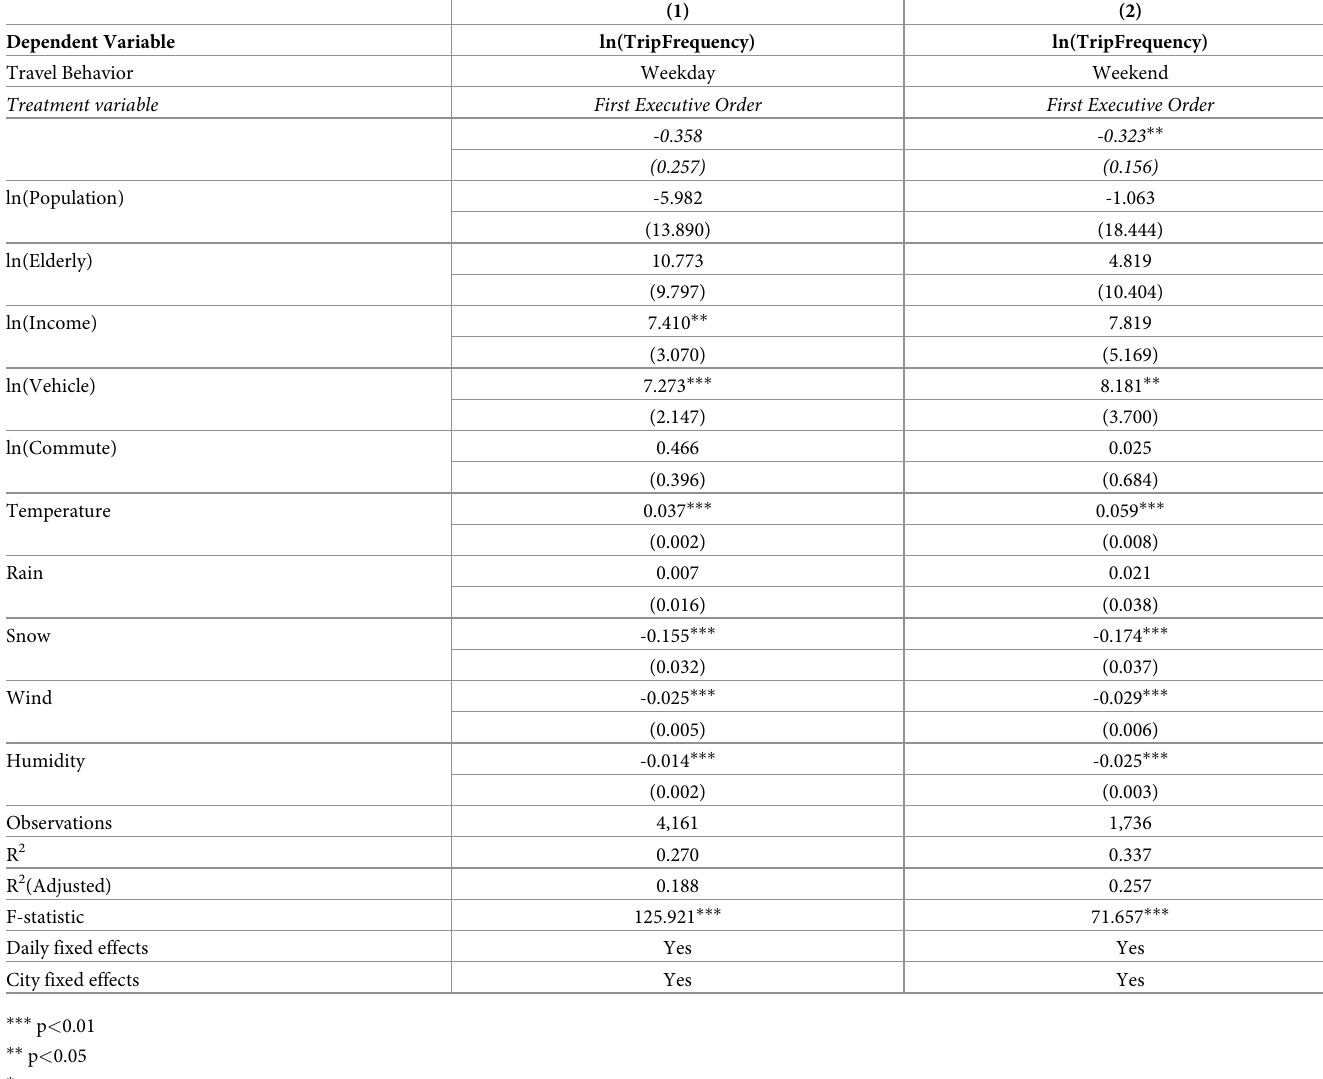
Table 6. Bike-sharing trip frequency: Weekday- and weekend-specific fixed-effects regression results where the treatment is the first executive